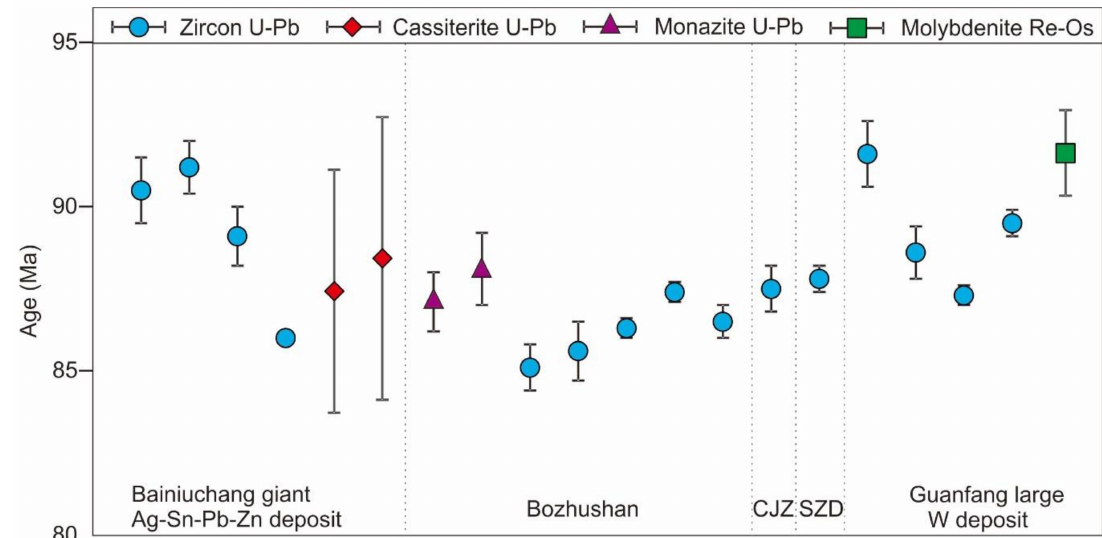
Figure 7. Compilation of geochronological data for the Bozhushan batholith and representative deposits, southeastern Yunnan district. Data sources: The Bainiuchang giant Ag–Sn–Pb–Zn deposit is from [20,21,25]; The Bozhushan area is from [4,25]; The Chenjiazhai (CJZ) area is from [4]; The Suozuodi (SZD) area is from [4]; The Guanfang large W deposit is from